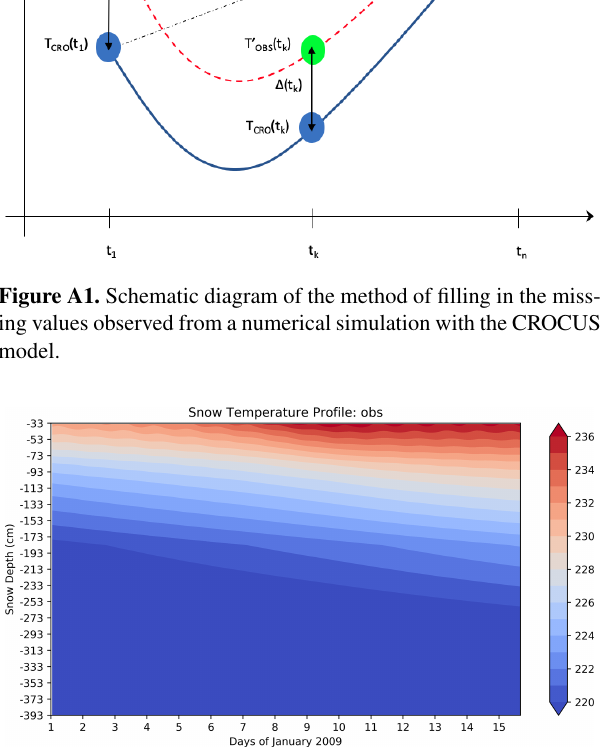
Figure A2. Temperatures in snow as a function of time for the 15d period in December 2009, interpolated to a fine vertical grid.